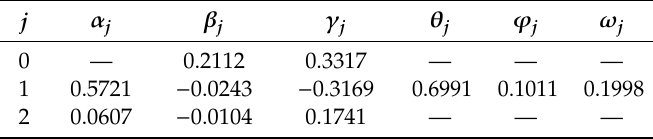
Table A6. Coe ffi cients of the ARMA model of heating systems ( J = 2).